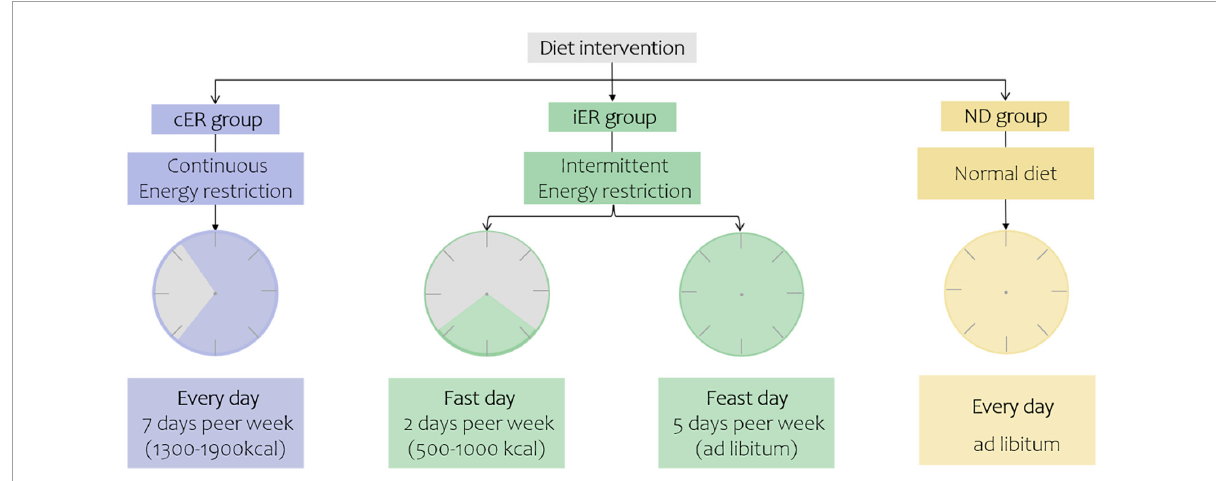
FIGURE2 Diet intervention of three groups. Continuous energy restriction, 30% of their daily recommended energy intake (approximately 500–1000 kcal) on 2 non-consecutive days every week and consumed food ad libitum for the other 5 days to maintain their normal energy intake. Intermittent energy restriction, 70% of their estimated energy requirements every day. Normal diet, 100% of their energy needs to be divided into three